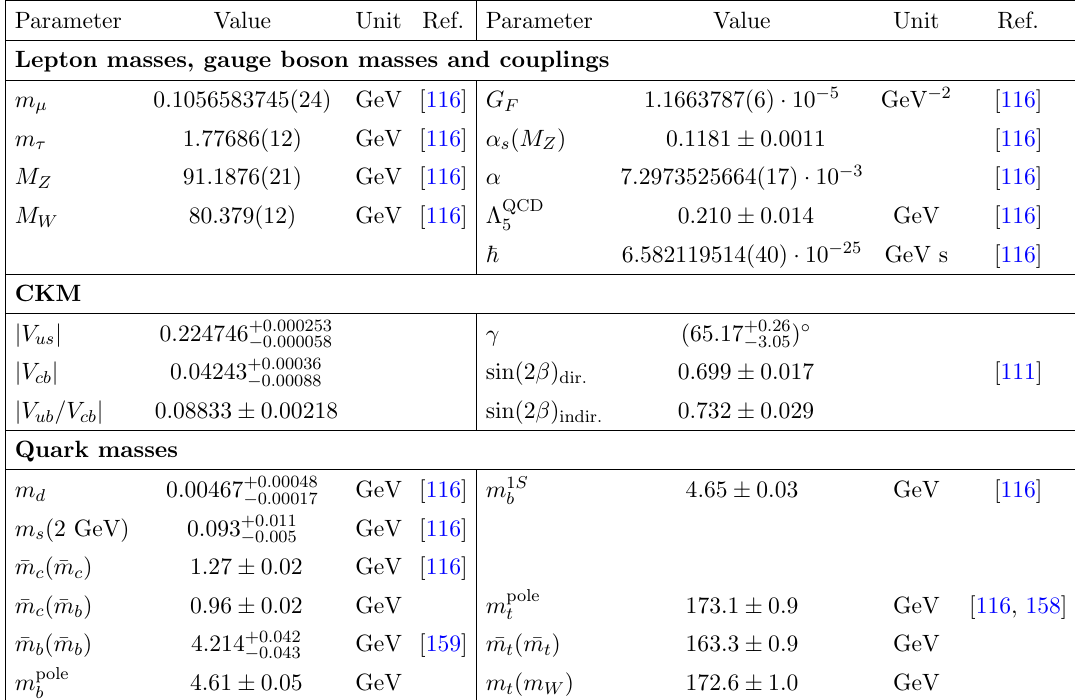
Table 17 . Values of the input parameters used for our numerical